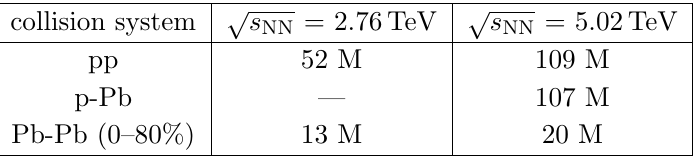
Table 1 . Number of events used in the analysis for various systems and energies. The analysis of Pb-Pb events was performed for the 0{80% centrality